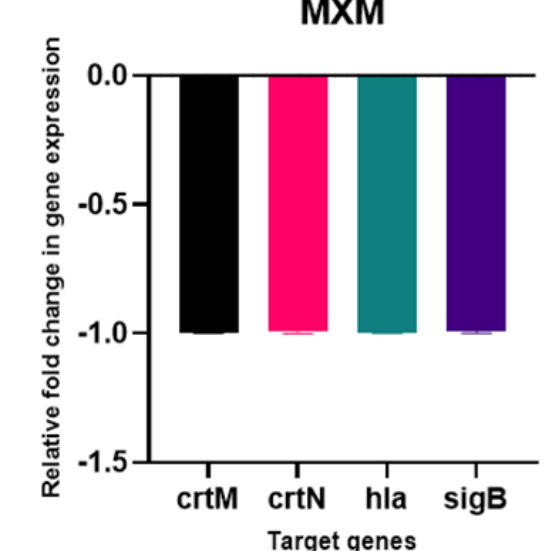
Figure 9. The influence of DC/MXM treatment (at sub-MICs of 47 µg/mL and 59 µg/mL for DC and MXM, respectively) on the expression of candidate genes involved in STX synthesis and virulence factors production when compared with the expression of the housekeeping gene 16S ribosomal RNA. Assays were performed in triplicates, and error bars indicate SDs from the mean. A p- value of < 0.05 is considered statistically significant.